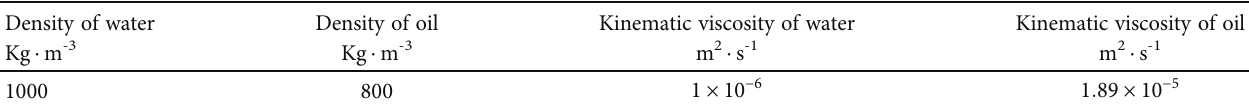
Table 2: Physical properties of fl uid.